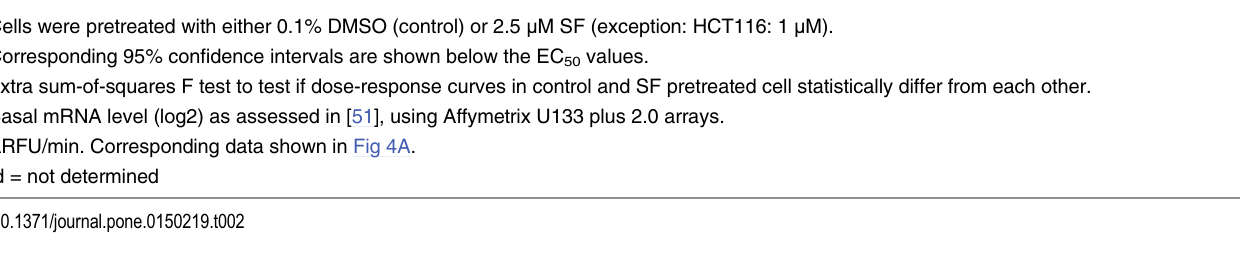
Table 2. PR-104A and CBL cytotoxicity in colon cell lines pretreated with SF. a HCEC1CT